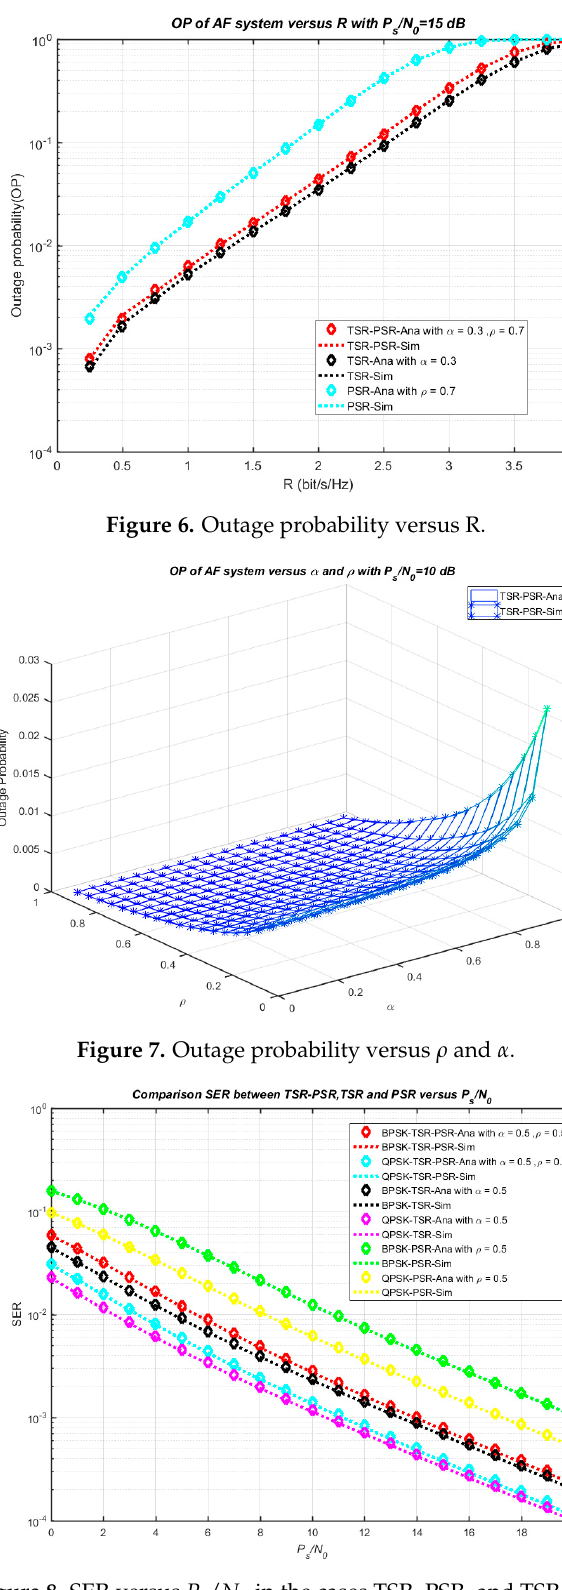
Figure 8. SER versus P s / N 0 in the cases TSR, PSR, and TSR–PSR.